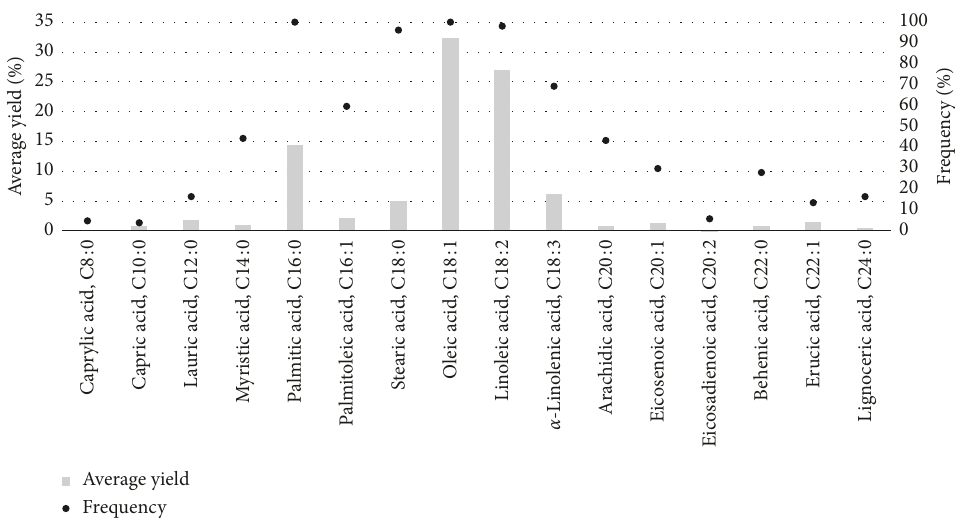
Figure 1: Percentage and frequency of each fatty oils in the biomasses reported in Table 1.